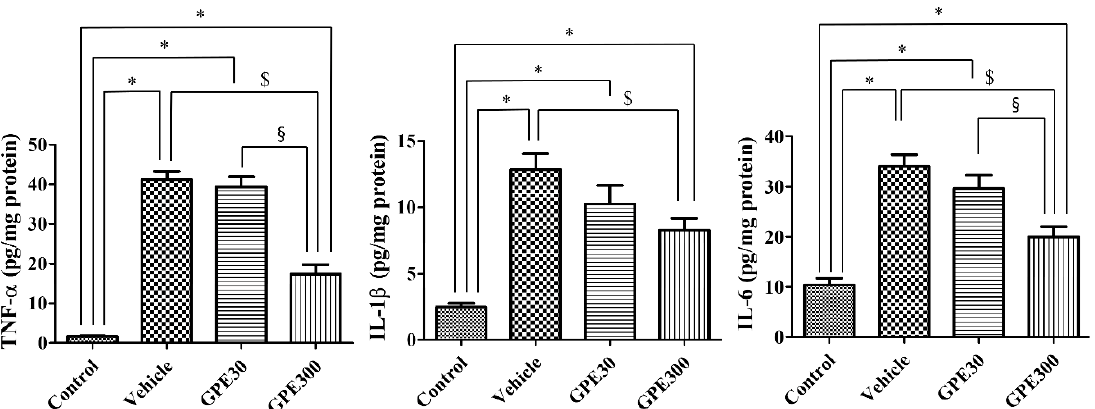
Figure 5. Levels of tumor necrosis factor- α (TNF- α ), interleukin (IL)-1 β , and IL-6 in the hippocampi of the control, vehicle- treated ischemic (Vehicle), 30 mg/kg GPE-R-treated ischemic (GPE30), and 300 mg/kg GPE-R-treated ischemic (GPE300) groups ( n = 7 per group, * p < 0.05 vs. the control group; $ p < 0.05 vs. the vehicle group; § p < 0.05 vs. the GPE30 group) are shown. Error bars represent standard errors of the means.